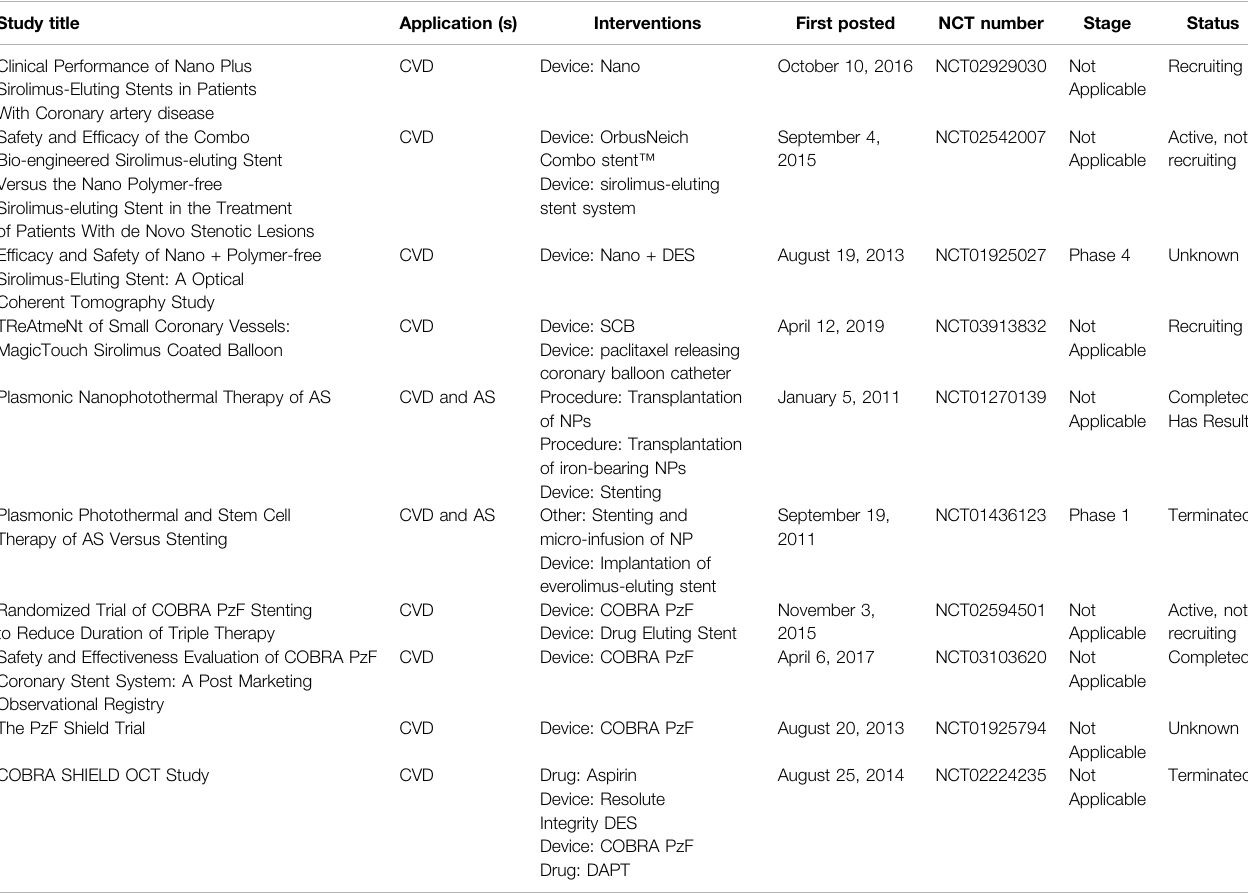
TABLE 3 | Summary of clinical trials related to NMs